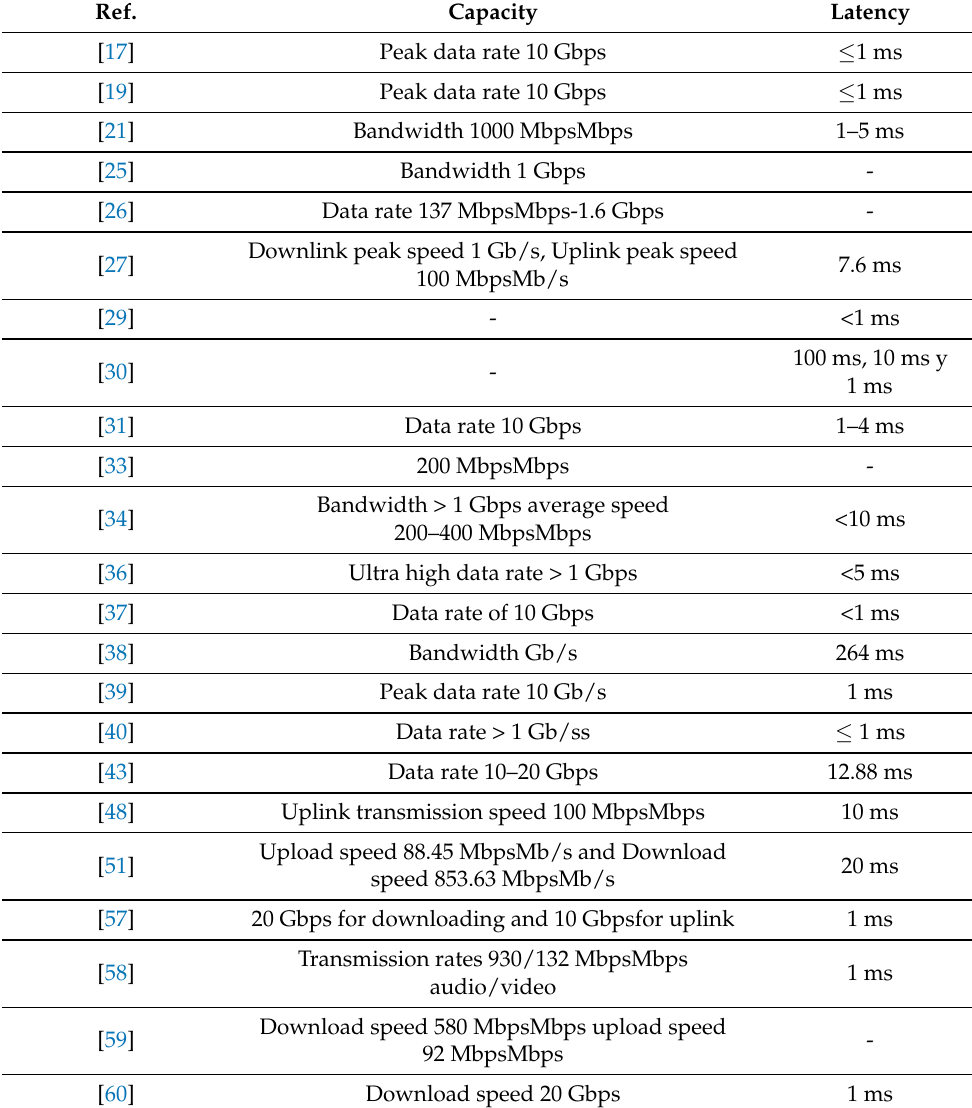
Table 4. Summary of technical requirements.